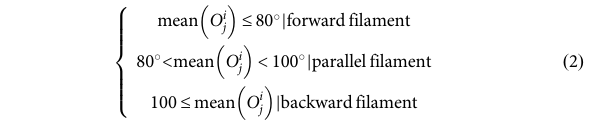
used in Supplementary Fig. 3b and Supplementary Fig.